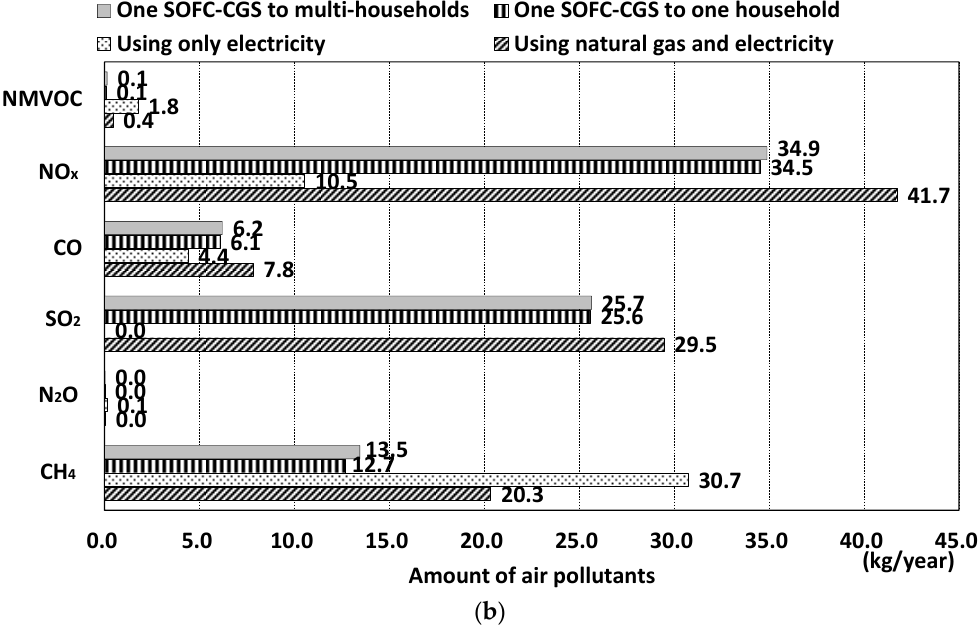
Figure 15. Comparison of air pollutant amounts of the building under the four different energy supply types. ( a ) Comparison of amount of CO 2 emission ( b ) Comparison of amount of other air pollutants emission.